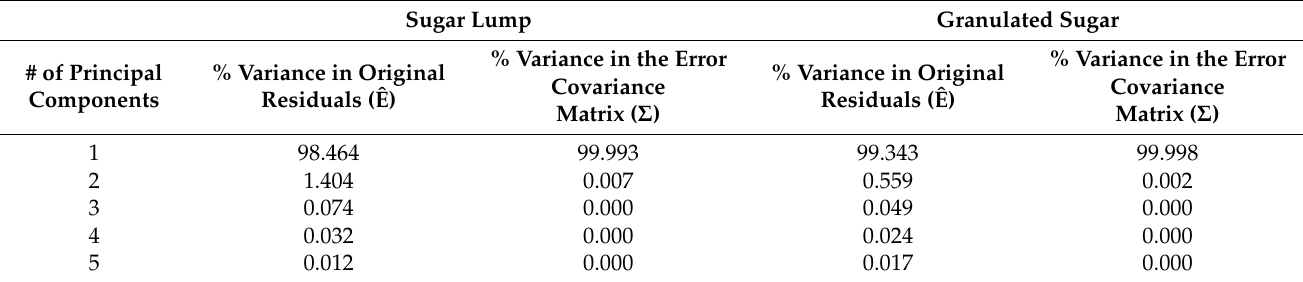
Table 2. Percentage of variance accounted for in the original matrix of residuals as well as in the error covariance matrix by PCA models of increasing complexity for AvaSpec-Mini-NIR